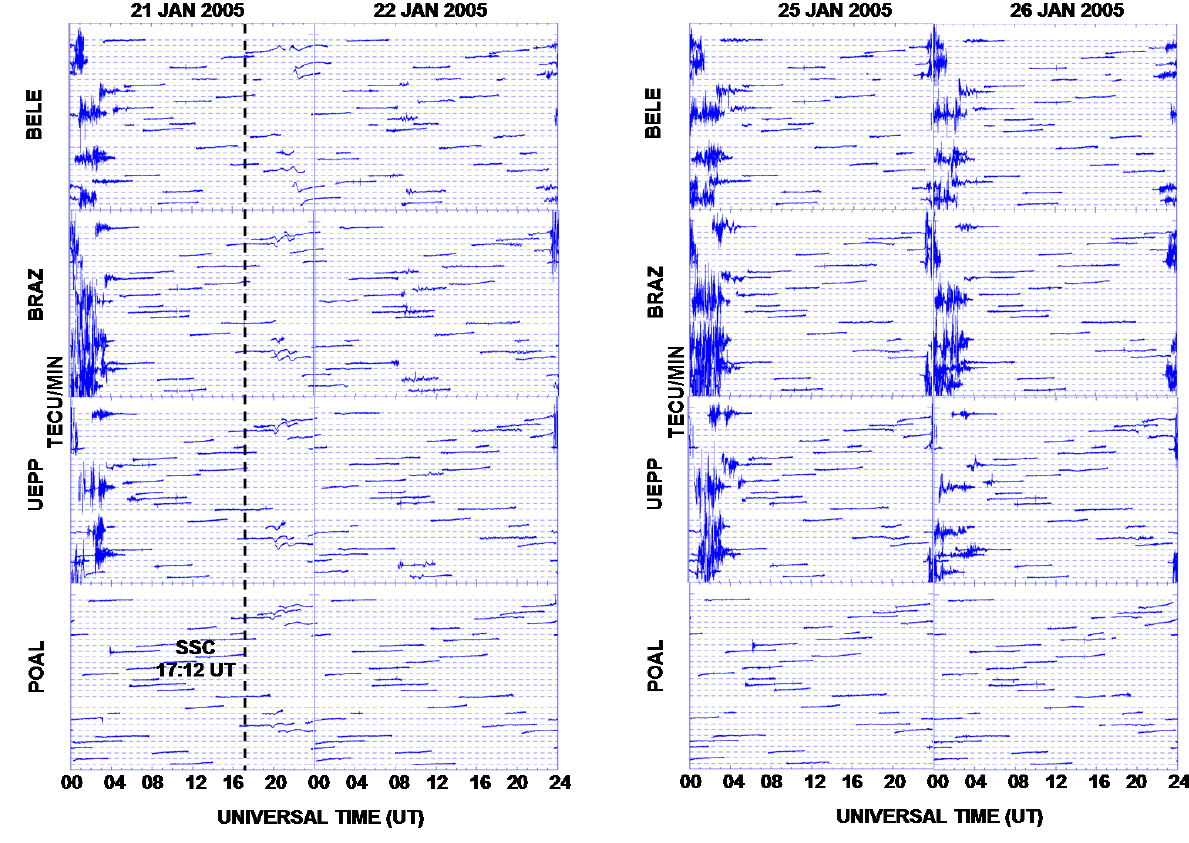
Fig. 9. Phase fluctuations (time rate change of TEC (TECUmin − 1 ) observed at Belem, Brasilia, President Prudente, and Porto Alegre on 21, 22, and 25 January